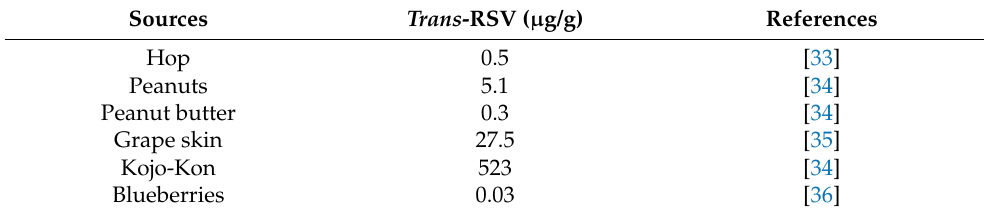
Table 1. Trans -resveratrol ( Trans -RSV) concentrations in various food